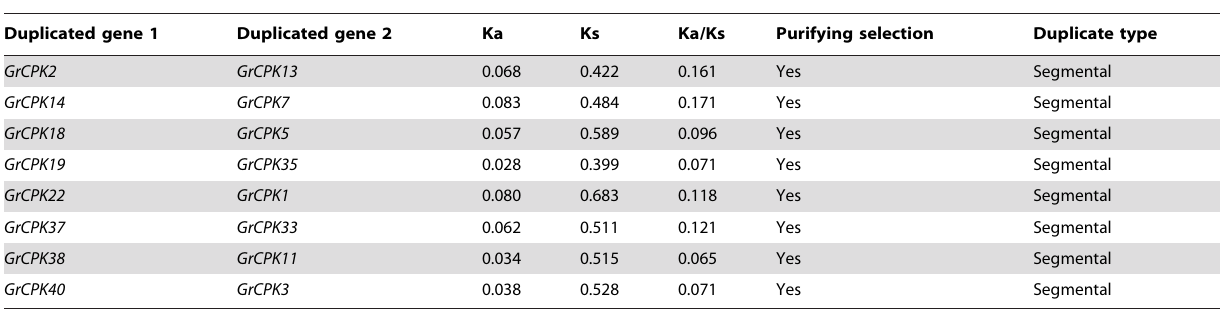
Table 2. Ka/Ks analysis for the duplicated gene pairs.